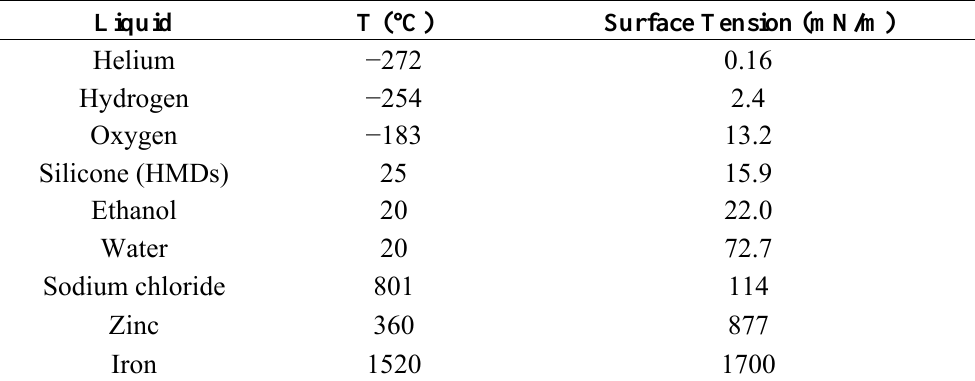
Table 1. Surface tension values of materials in their liquid phase